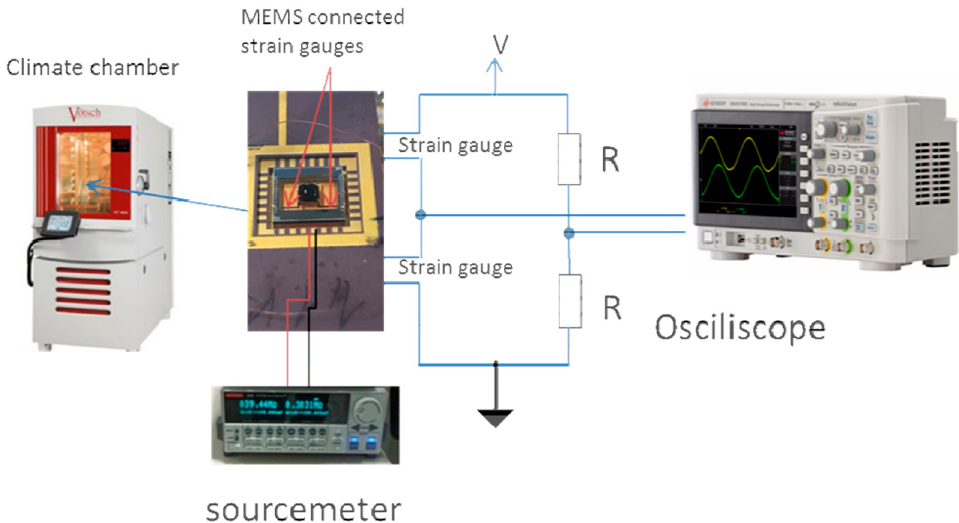
Figure 2. Experimental setup composed of a humidity chamber to control the humidity and temperature applied to the MEMS. The output was registered by a sourcemeter and an oscilloscope to obtain the resistance of the GO/PVA film and the oscillation frequency of the bridge.